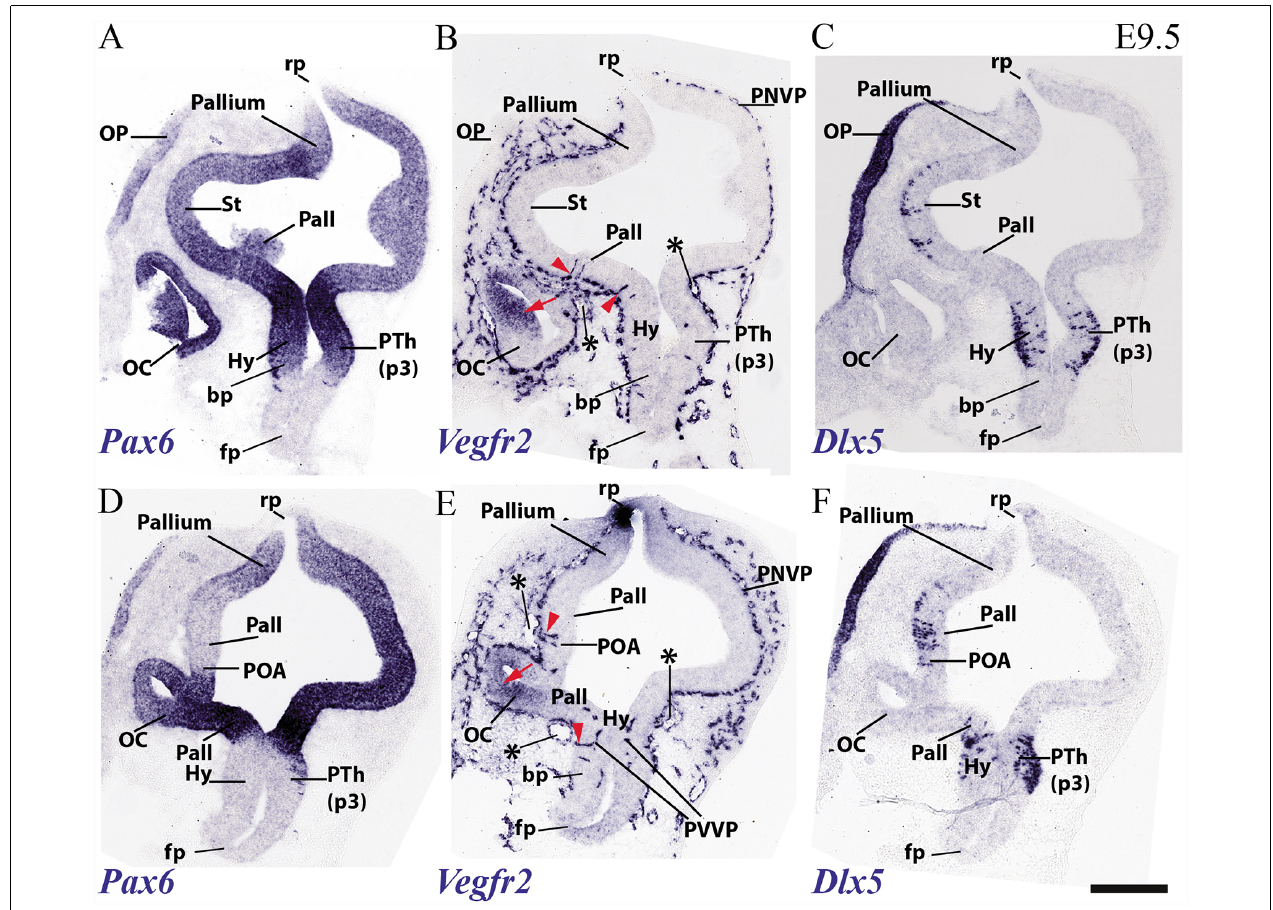
FIGURE 5 | Transversal sections through a mouse secondary prosencephalon and diencephalon at E9.5 showing PNVP vascularization and first perforant vessels (Vegfr2; B,E ), compared in consecutive sections with markers of telencephalic pallium and striatum (Pax6; A,D ) and telencephalic subpallium and part of alar hypothalamus (Dlx5; C,F ). Red arrowheads: perforant vessels, red arrow: non-vascular expression of Vegfr2 at the retinal primordium of the optic vesicle. Asterisks: presumed venous sinuses. See schematic representation of plane of section in Figure 3H . Scale bar: 200 µ